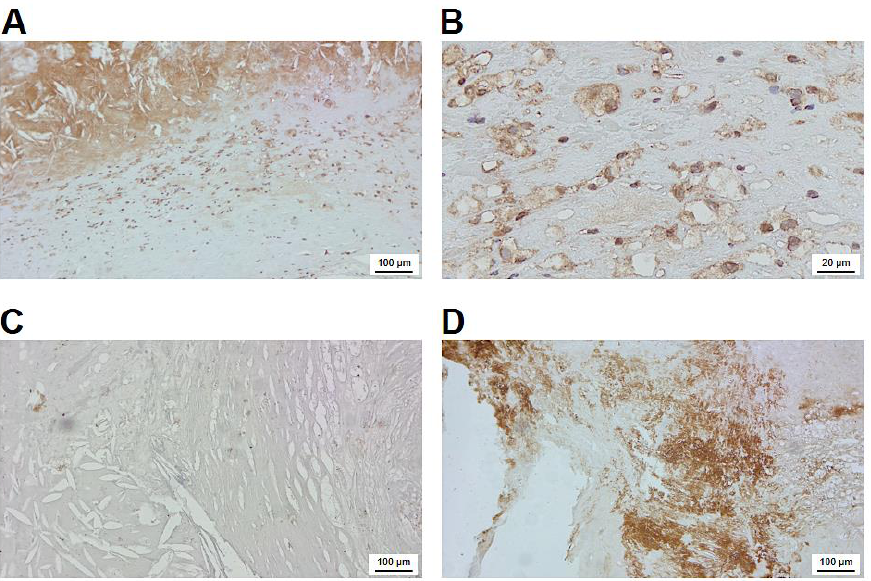
Figure 4. Immunohistochemical visualization of FXIII-A and cross-linked protein structures in the atherosclerotic plaque. ( A ) FXIII-A of cellular and extracellular localization in the atherosclerotic plaque. ( B ) FXIII-A-containing macrophages in the plaque at higher magnification. ( C ) Negative control for FXIII-A staining. ( D ) Protein mass cross-linked through N ε -( γ -L-glutamyl)-L-lysyl bonds in a non-cellular part of the sclerotic plaque.